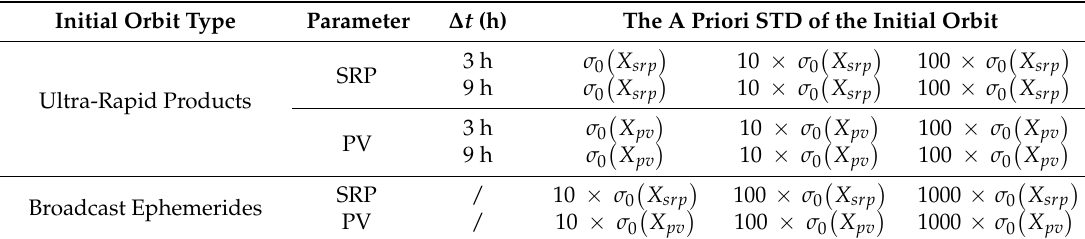
Table 4. Experiment scheme of the convergence analysis in normal period.